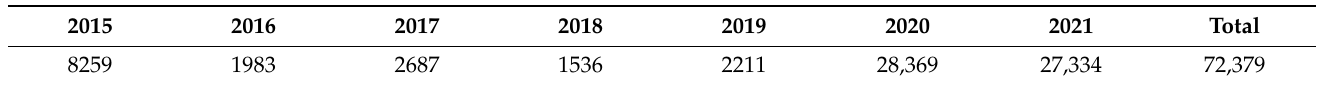
Table 1. Number of Antibiotic Guardian pledges from pharmacy teams between 2015 and 2021 from the United Kingdom.